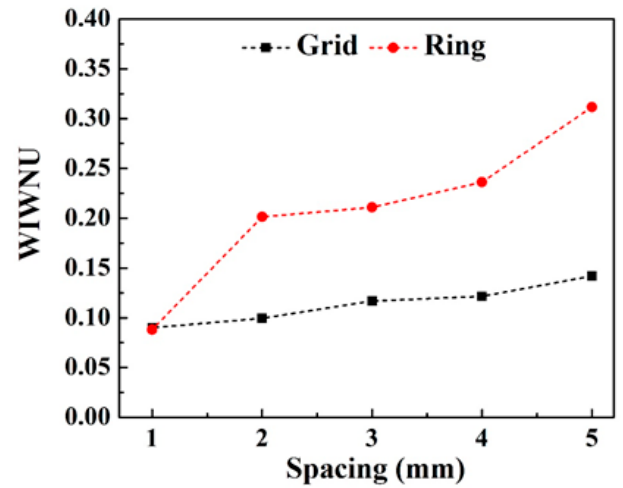
Figure 5. Calculated non-uniformity of trajectory with concentric ring and grid arrangements of the sol–gel balls.